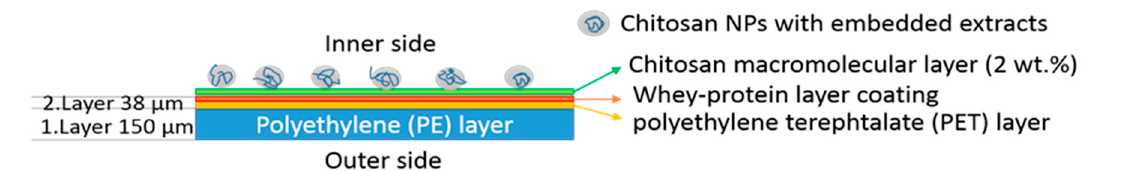
Figure 2. The scheme of multilayer whey protein-based film.